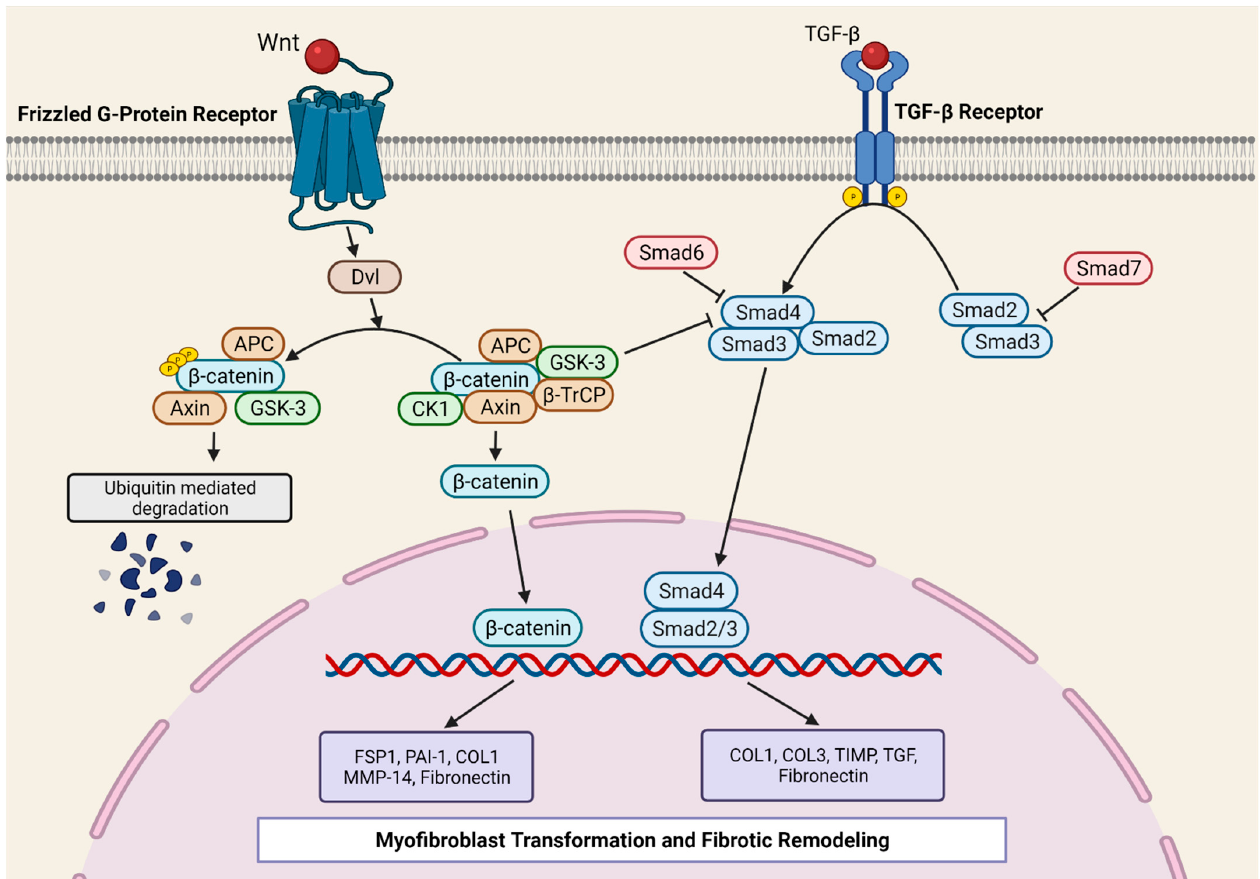
Figure 1. Co-operation of canonical Wnt/ β -Catenin and TGF- β 1-SMAD3 signaling in fibrosis. In the canonical TGF- β 1- SMAD3 pathway, the binding of ligands (TGF- β ) to TGF- β R leads to the phosphorylation of R-SMADs (SMAD2 and SMAD-3). Phosphorylated R-SMADs promote the association with Co-SMAD (SMAD4), resulting in nuclear translocation to mediate the pro-fibrotic gene program. The sketch shows the critical crosstalk between the canonical TGF- β 1 pathway and the Wnt/ β -catenin signaling. Wnt/ β -catenin signaling has a dual role in pro-fibrotic signaling: (I) the direct effect of nuclear β -catenin on pro-fibrotic gene program and (II) an indirect effect through the modulation of the TGF- β 1 pathway. APC = Adenomatous Polyposis Coli; β -TrCP = β -transducin repeat-containing protein CK1; Col = Collagen; Dvl = Disheveled; FSP1 = Fibroblast-specific protein 1; GSK-3 = Glycogen synthase kinase 3; MMP = Matrix metalloproteinases; PAI-1 = Plasminogen activator inhibitor-1; Smad = Contraction of Sma and Mad (Mothers against decapentaplegic); TGF- β 1 = Transforming growth factor beta 1; TIMP = Tissue inhibitors of MMPs.